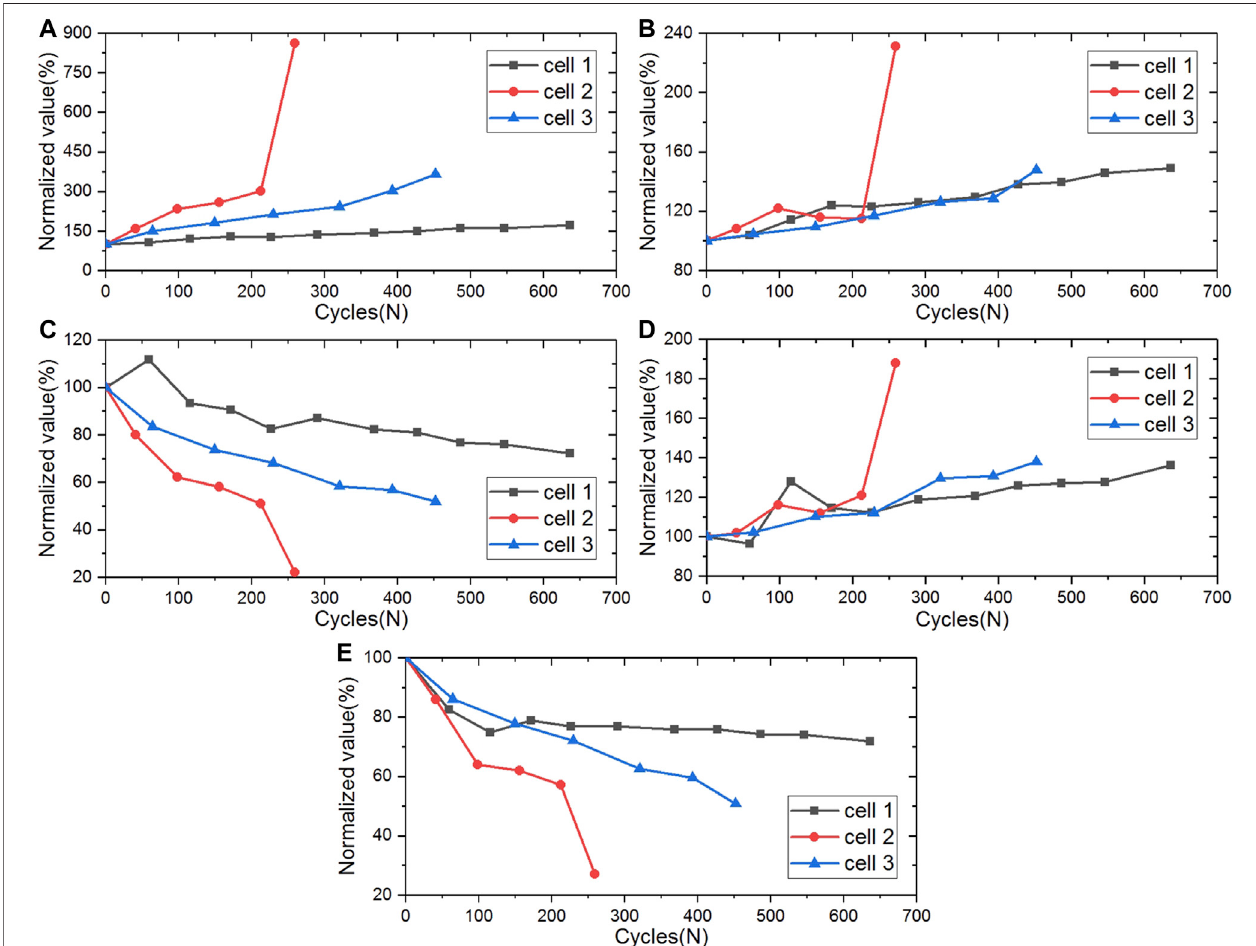
FIGURE 5 | Degradation tendencies of ECM parameters under 70% SOC for Cells 1 – 3: (A) R 0 , (B) R p , (C) C p , (D) R d , and (E) C d .